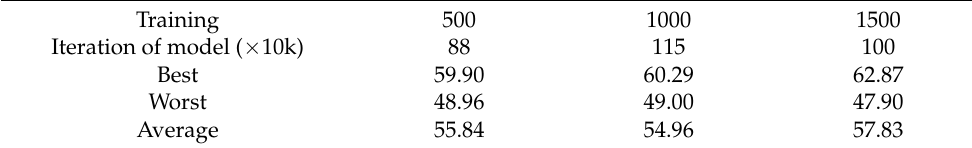
Table 7. YOLOv4 Analysis of the training process (mAP = 0.5, Testing sets = 166). Training 500 Iteration of model ( ×